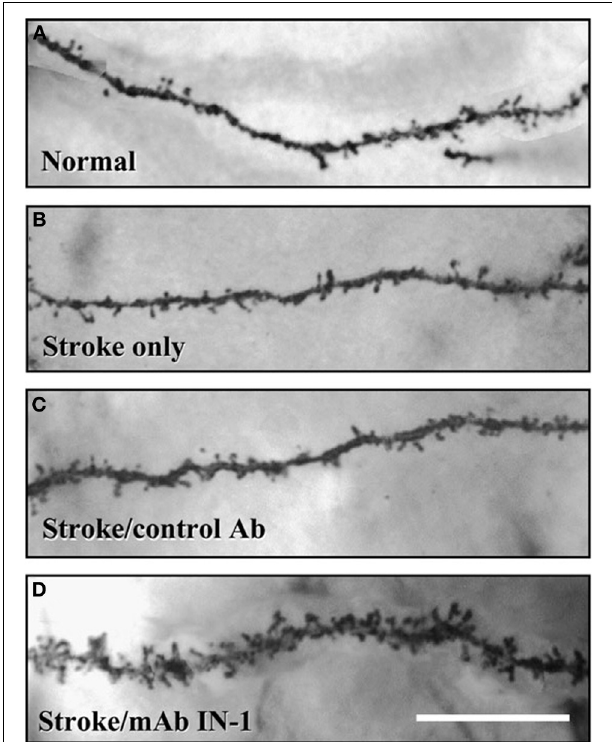
FIGURE 5 | Both dendritic length and spine density (shown here) in the contralateral forelimb cortex is enhanced by antibodies to NoGo-A (After Papadopoulos et al., 2006).